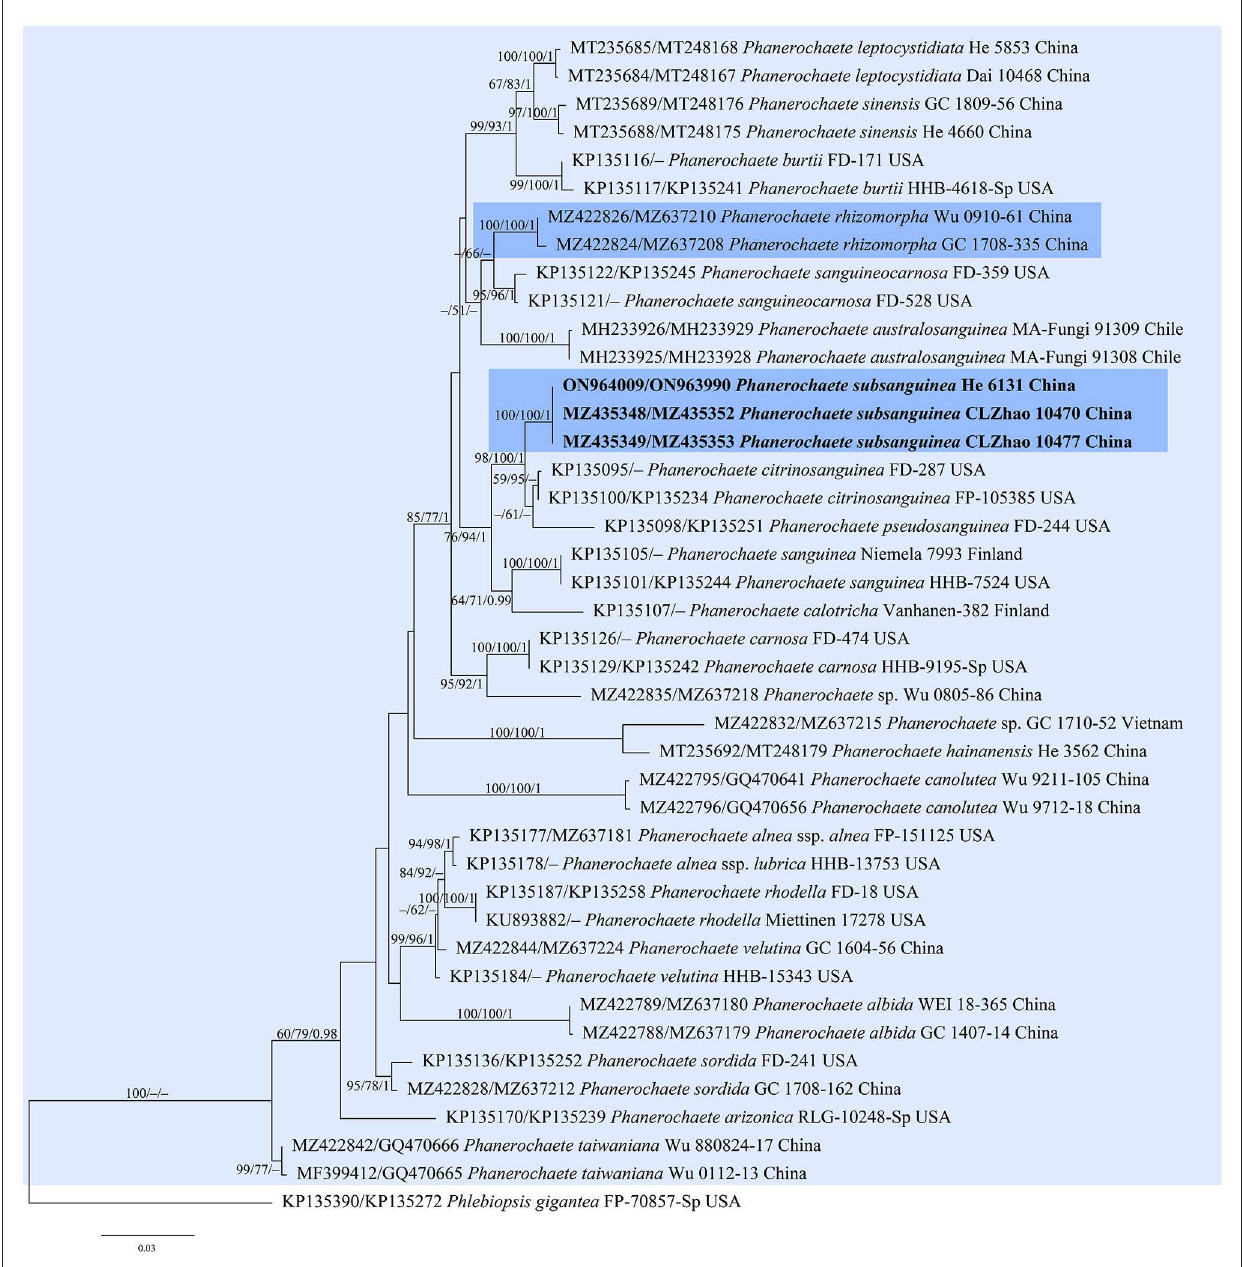
FIGURE4 Phylogenetic tree obtained from ML analysis of the ITS-nrLSU sequences of Phanerochaete . Branches are labeled with parsimony bootstrap values ( ≥ 50%, first), likelihood bootstrap values ( ≥ 50%, second), and Bayesian posterior probabilities ( ≥ 0.95, third). The new replacement names are set in bold and